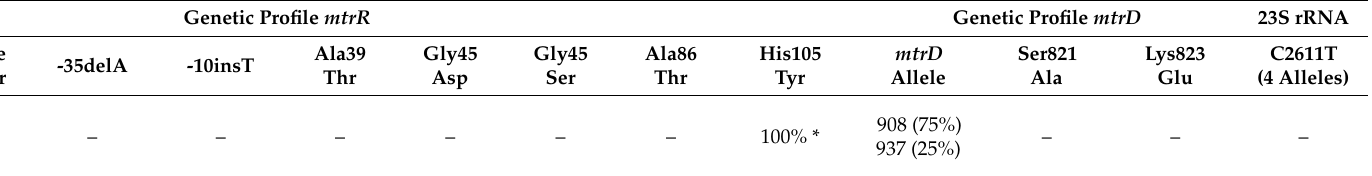
Table 1. Genetic profiles of N. gonorrhoeae